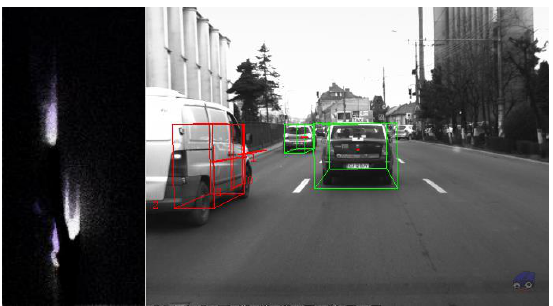
Figure 9. Obstacle detection results: ( Left ) the dynamic occupancy grid; and ( Right ) the extracted cuboids.